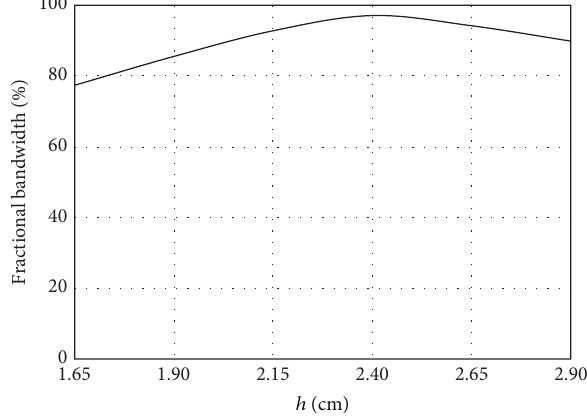
Figure 3: Fractional bandwidth of the resonant frequency at 2.3 GHz as a function of ℎ ( 𝑎 = 7.20 cm, 𝑏 = 3.60 cm, 𝑑 = 2.60 cm, and 𝑟 𝑐 = 1.30cm).